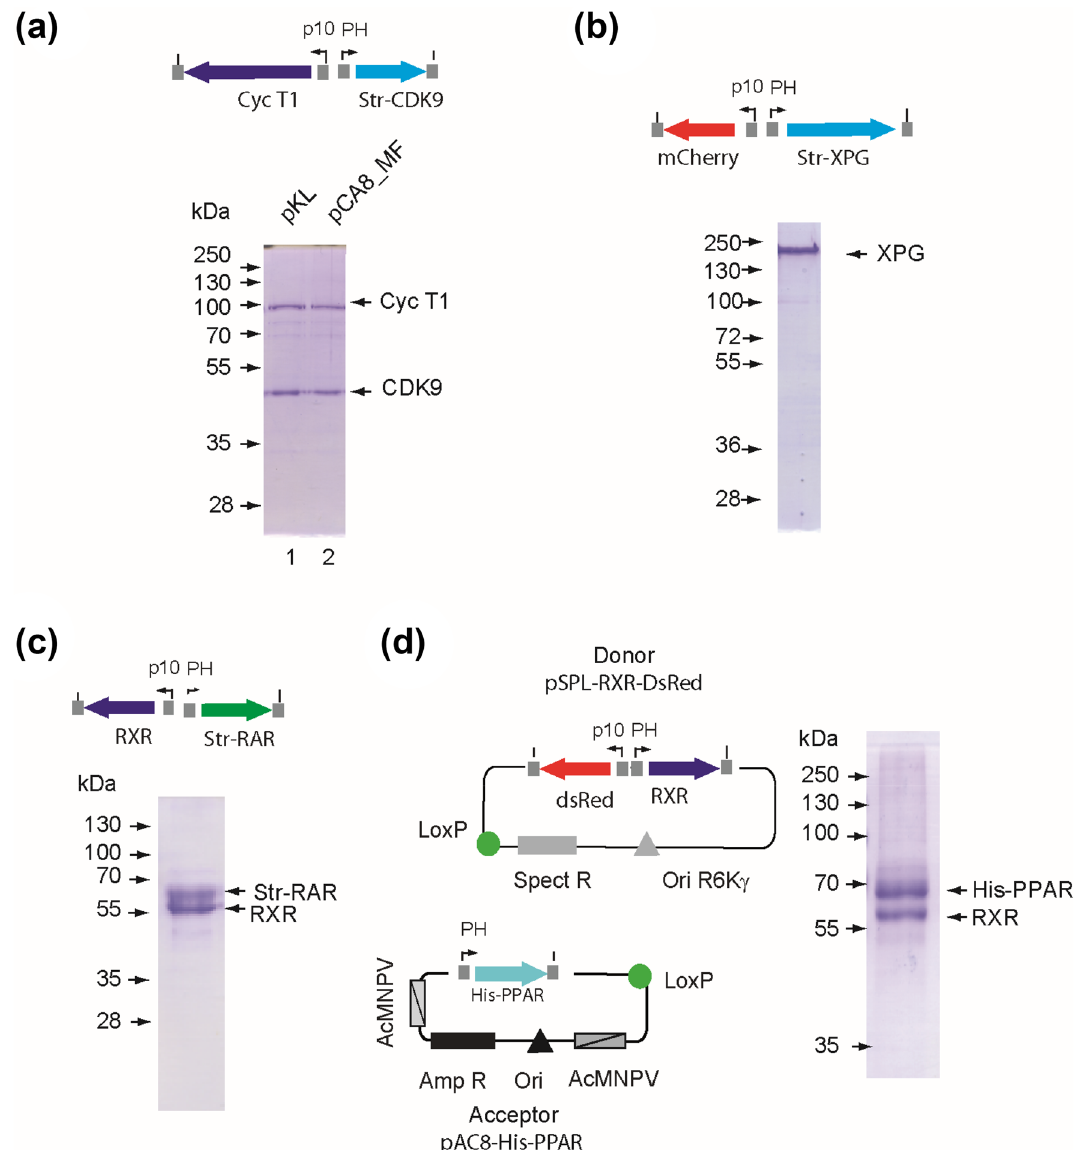
Figure 3. Production of binary complexes. ( a ) CDK9/cyclin T1. The cDNAs encoding Strep-CDK9 and cyclin T1 were cloned into the dual expression cassette of the pKL and pAC8_MF transfer vectors that were used to produce the complex with a virus obtained using the MultiBac toolkit (Tn7 mediated transposition, pK, lane 1) or virus generated with the HR-Bac toolbox (pAC8_MF, lane2). Affinity purified complexes from 10 6 cells were analyzed using a Coomassie-stained 12.5% SDS gel. ( b ) XPG. Affinity purified Twin-strep tagged Komagataella phaffii (Pichia pastoris) XPG homologue produced using the pMF-mCherry/XPG transfer vector and analyzed using a Coomassie-stained 12.5% SDS gel. ( c ) RAR/RXR. Affinity purified Strep-tagged RAR/RXR heterodimer produced using the pMF-RAR/RXR transfer vector analyzed using a Coomassie-stained 12.5% SDS gel. ( d ) Schematic representation of the acceptor vector bearing the His-tagged PPAR coding sequence (light blue) (pAC8-His-PPAR) and the donor vector containing the RXR cDNA (dark blue) under the control of PH promoter. A fusion vector was obtained by Cre-mediated recombination using the lox P sites (green circles) of the acceptor and donor (left panel). Affinity purified His-tagged PPAR/RXR heterodimer produced from the fusion plasmid analyzed on a Coomassie-stained 12.5% SDS gel (right panel). Full-length gels are presented in Suppl. Fig.